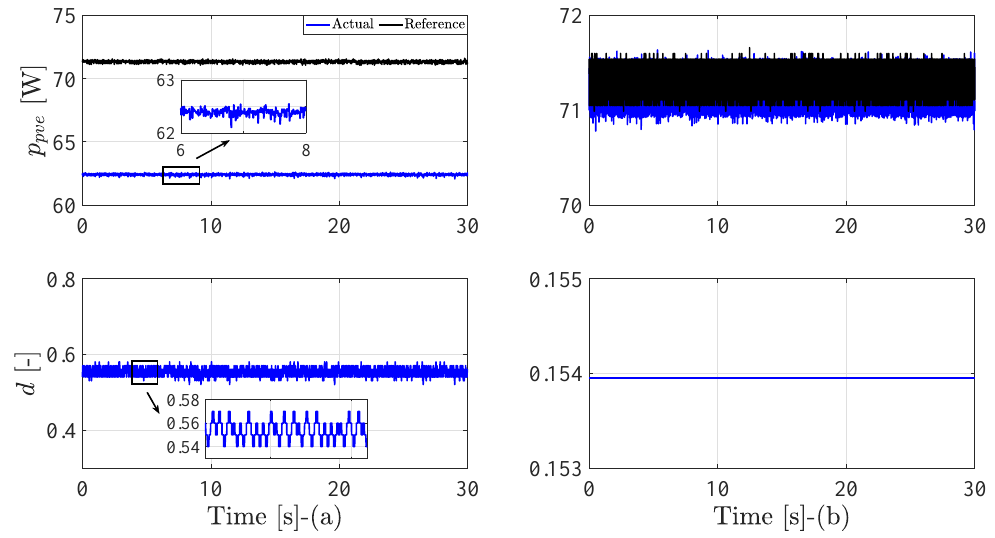
Figure 10. The performance of the MPPT methods under partial shading conditions with resistive load (the global peak is on the right side): ( a ) The P&O method ( b ) The particle swarm optimiza- tion technique.